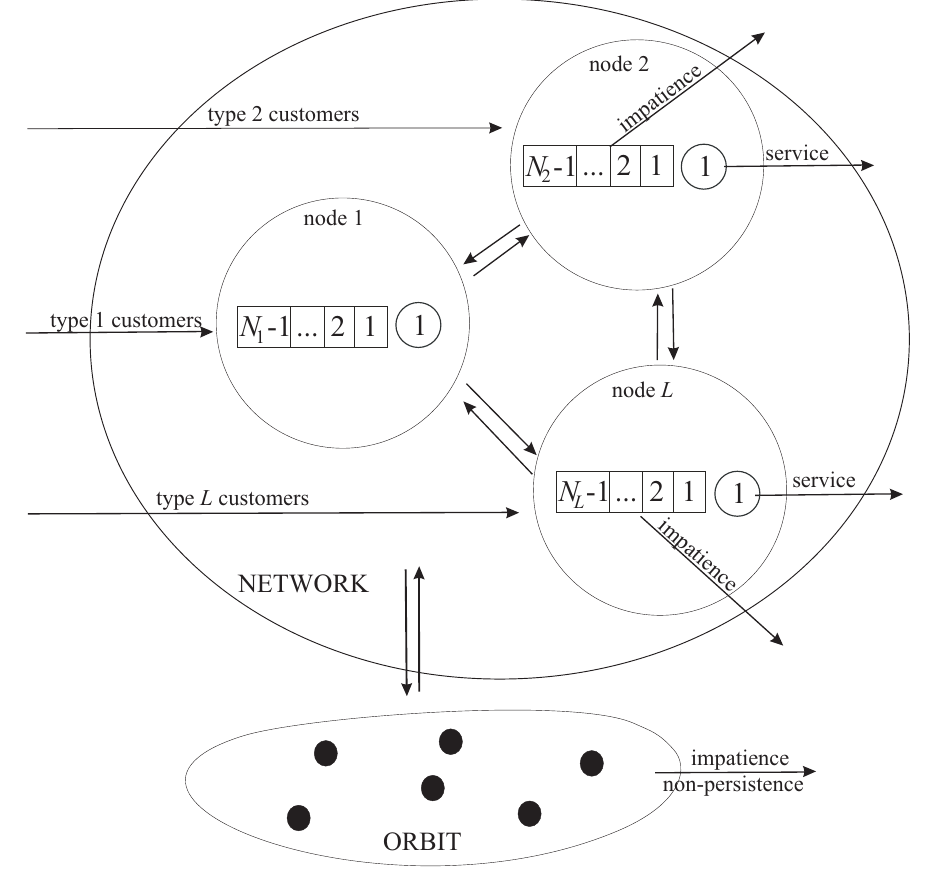
Figure 1. Retrial queuing network under